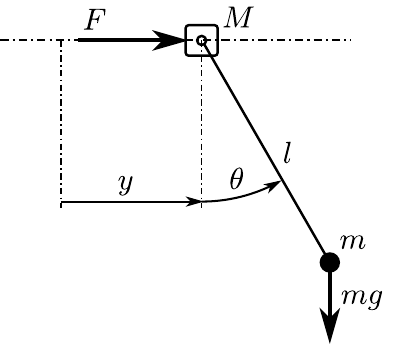
Figure 1. Model of a pendulum on a sliding